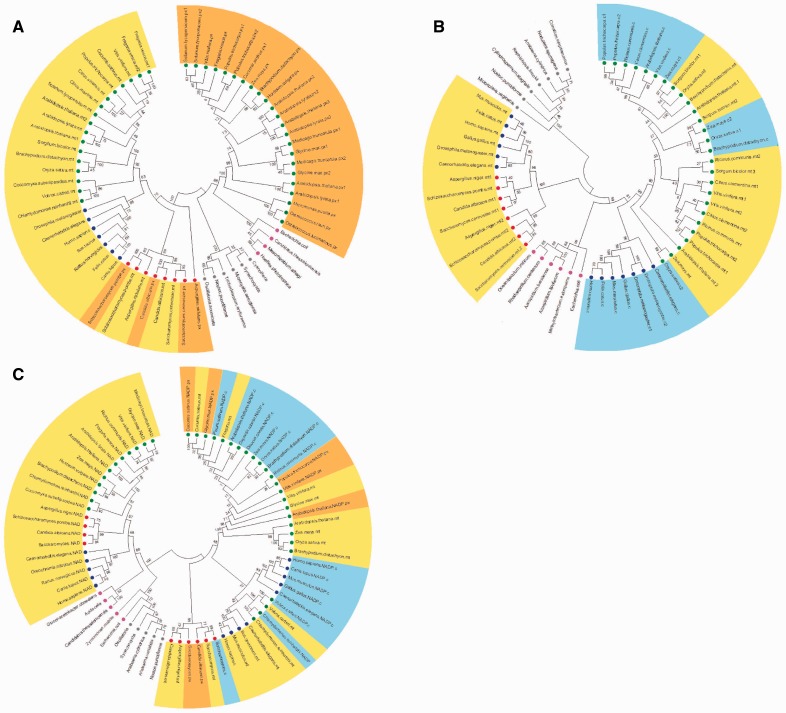
The phylogenetic tree of (A) CS, (B) aconitase, and (C) IDH. Trees were built using putative amino acids sequences from CS, aconitase, and IDH. Subcellular compartments are highlighted by background colors and in all cases figures follow the same pattern: Mitochondrial isoforms are highlighted by yellow background, peroxisomal isoforms by orange background, and cytosolic isoforms by blue background. Sequences of putative proteins from plants are highlighted by green circle, yeast by red circle, animals by blue circle, algae by dark green circle, bacteria by pink circle, and cyanobacteria by gray circle.